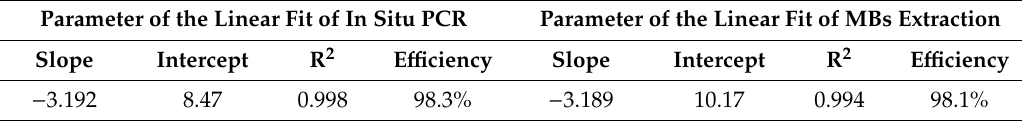
Table 3. Parameters of calibration curves of in situ PCR and magnetic beads (MBs) extraction. Parameter of the Linear Fit of In Situ